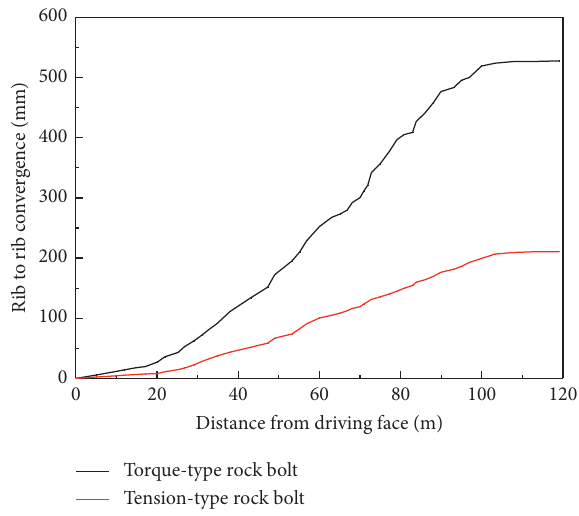
Figure 10: Convergence of head entry of the working face 6208 during